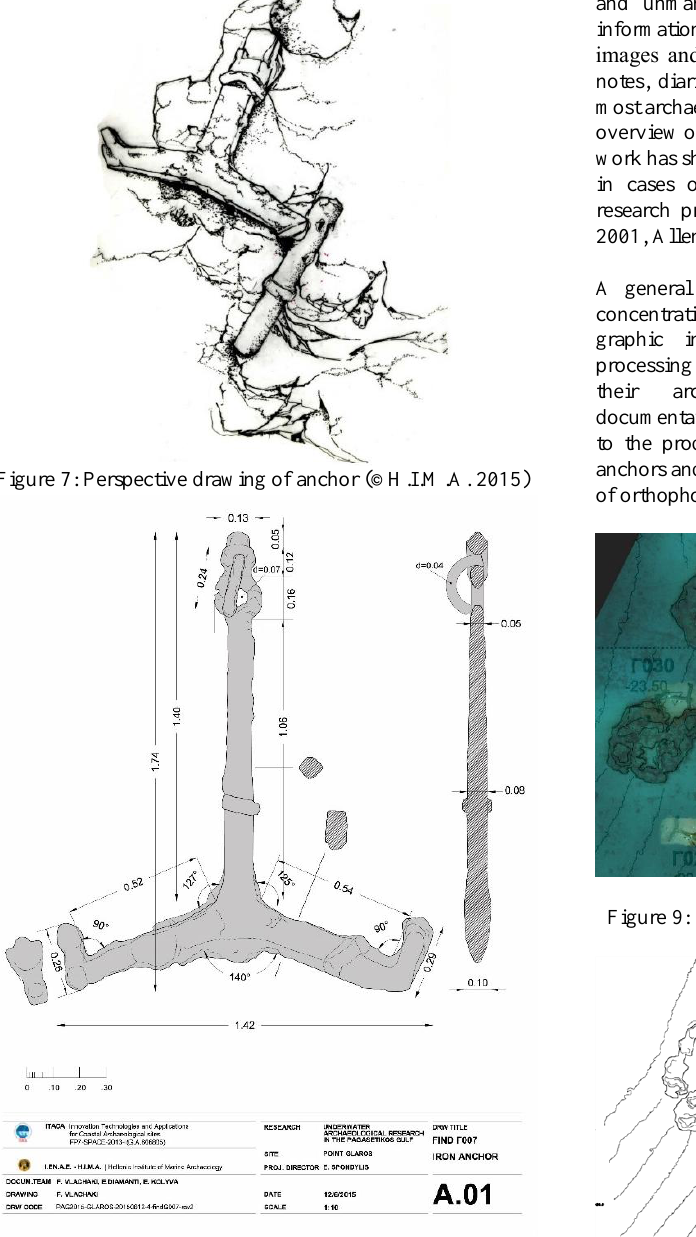
Figure 8: Detailed measurements on anchor Γ007 (©H.I.M.A. 2015)